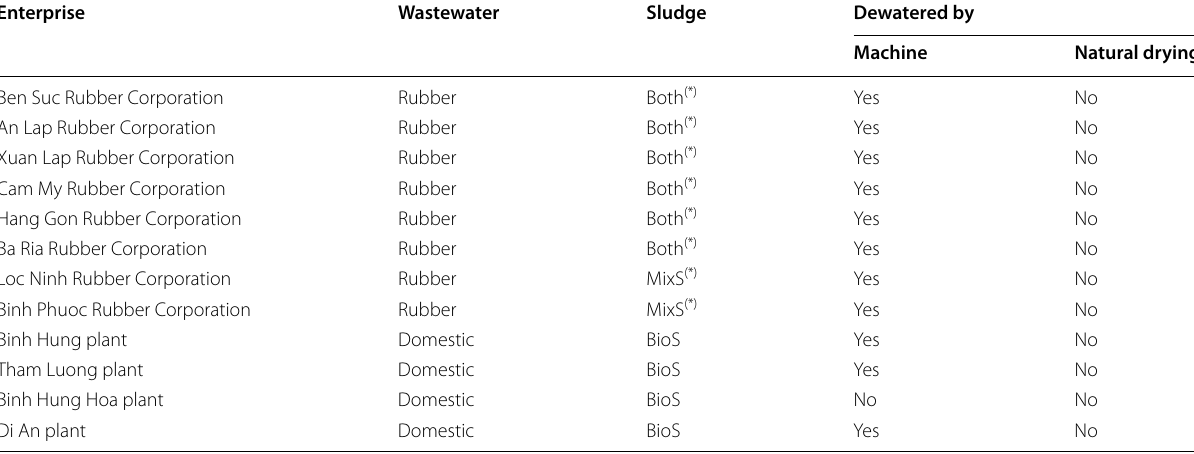
MixS (*) : CheS and BioS are mixed before dewatering Both (*) : CheS and BioS